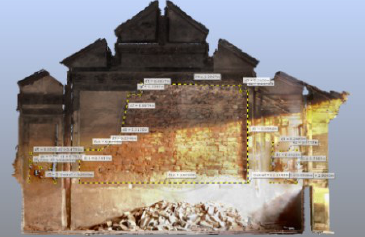
Figure 5: Application of 3D Laser scanning Technology